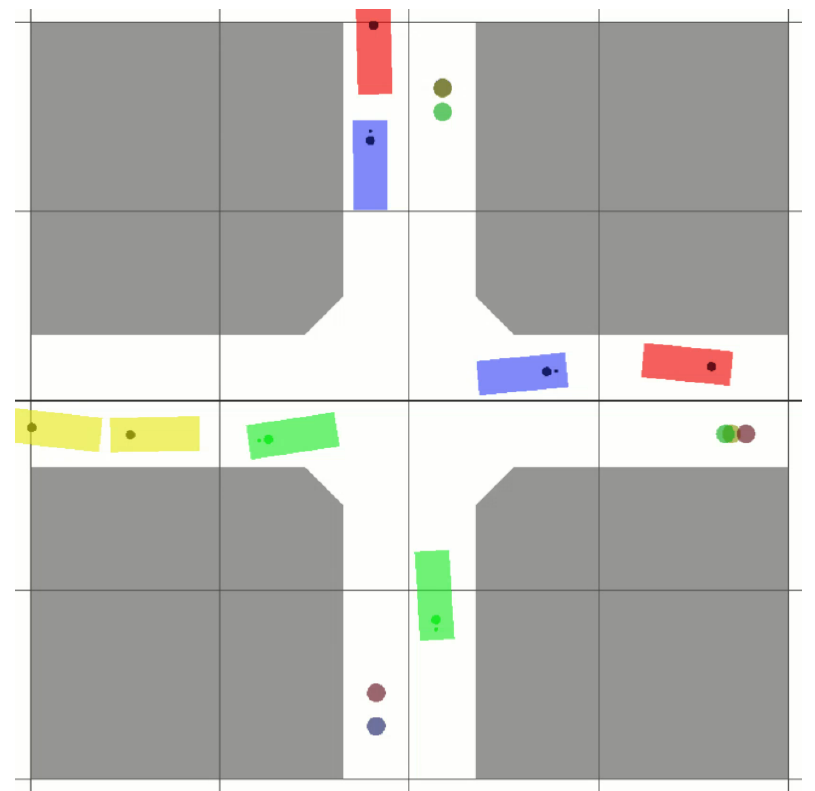
Figure 6. The crossroad scenario, with multiple agents each aiming at a different end goal, which is